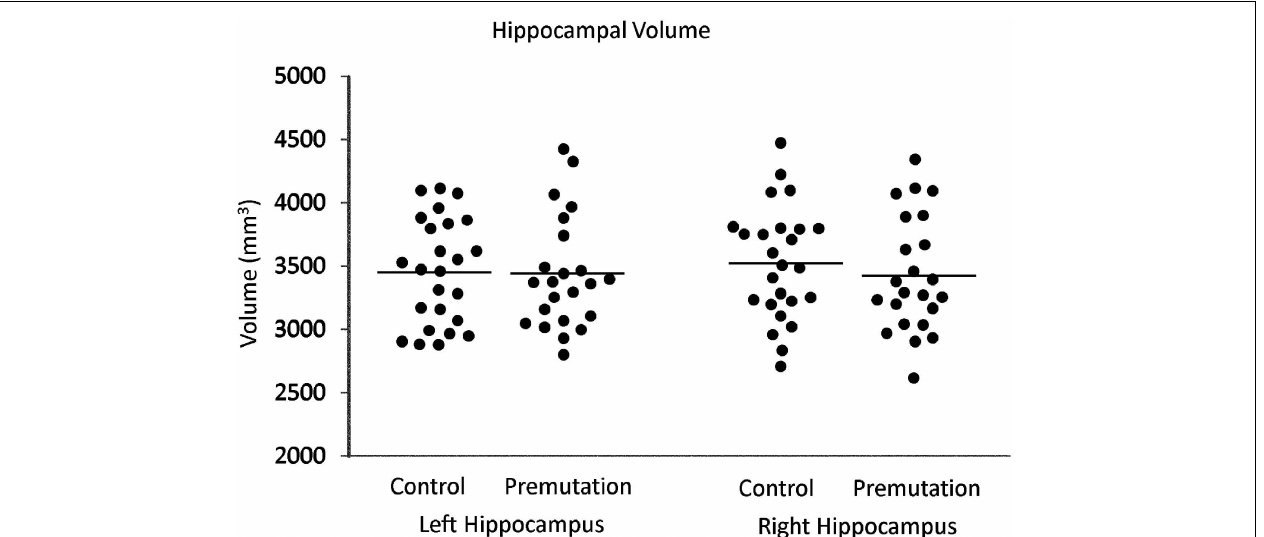
FIGURE 2 | Distributions of left and right hippocampal volume (corrected for total cerebral volume) in premutation carriers and